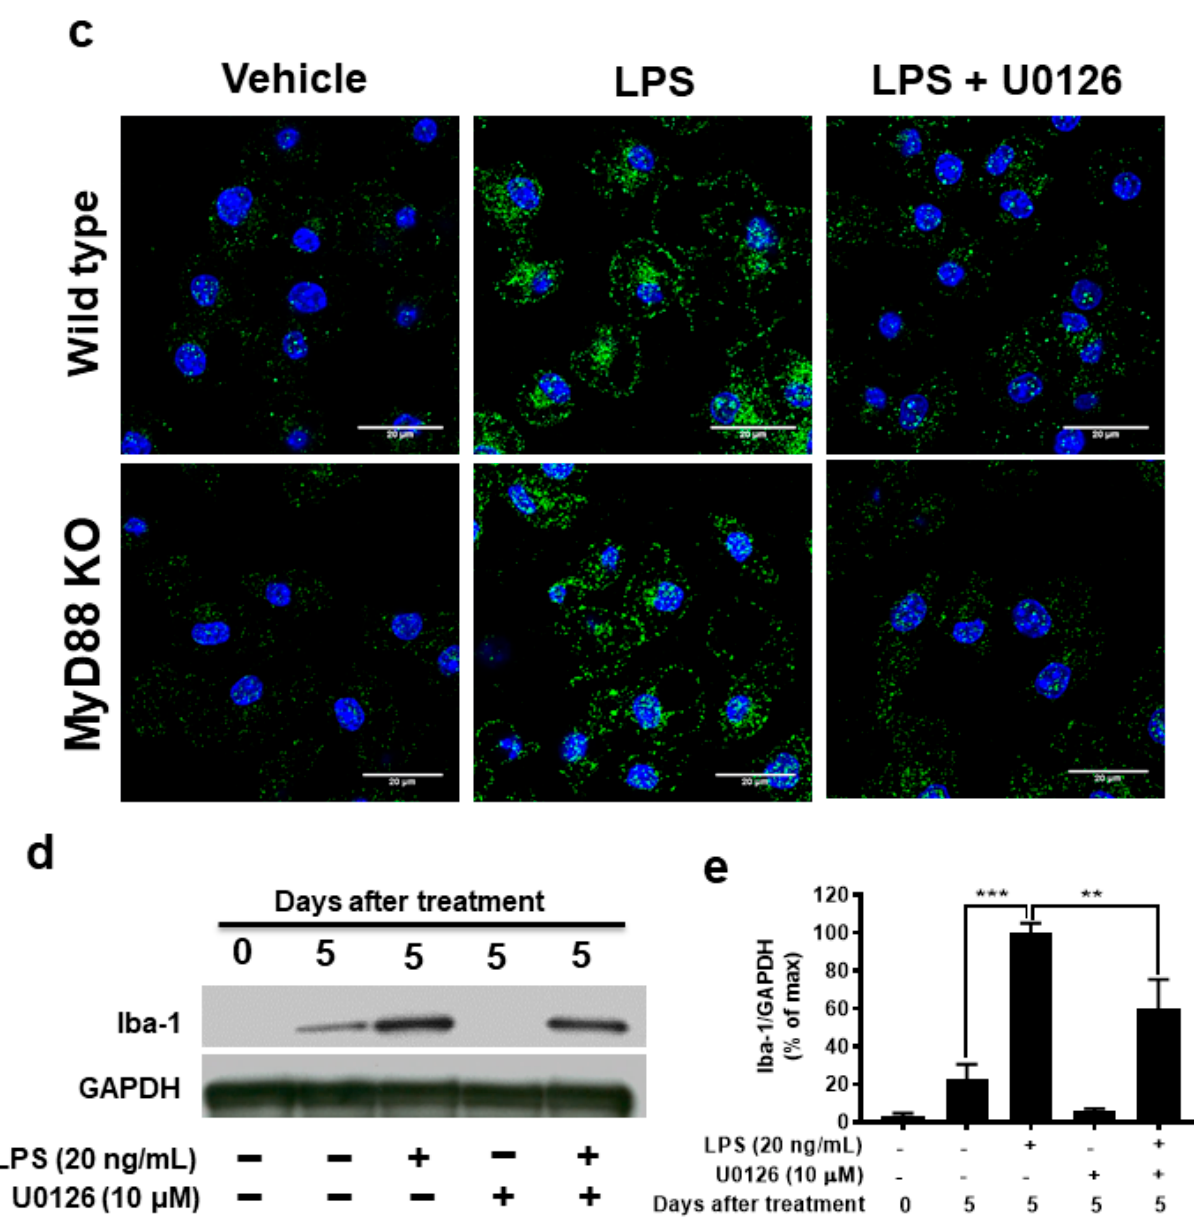
Figure 6. A prolonged increase in ERK1/2 phosphorylation is associated with MAC1-NOX2-elicited reactive microgliosis. Microglia from wild type, MAC1 KO, and MyD88 KO mice were treated with LPS. Cell pellets were collected at various time points for detecting the quantity of both phosphorylated-ERK1/2 or total ERK1/2 ( a ). ( b ) Quantification of ERK1/2 profiles. ( c ) Microglia from wild-type and MyD88 KO mice were stimulated with LPS for 30 min followed by Erk1/2 inhibitor U0126 (10 μ M) for another 30 min. At the end of incubation, cells were fixed and stained with p47 phox , scale bar = 20 μ m. ( d ) Neuron-glial cultures from wild-type mice were stimulated with LPS and followed by treating with ERK1/2 inhibitor one day after LPS stimulation. Five days after U0126 treatment, the cell pellets were collected for Iba-1 Western blot analysis. ( e ) Quantification of Iba-1 density in ( d ). Data show mean ± SEM from 3 independent experiments. * p < 0.05; ** p < 0.01; *** p < 0.001. To further determine whether the long-lasting of ERK1/2 phosphorylation affects the downstream effector NOX2 activation, we stimulated both wild-type and MyD88 KO mi- croglia with LPS for 30 min followed by treatment with ERK1/2 inhibitor U0126 (10 μ M) for another 30 min. In Figure 6c, analysis of immunostaining of p47 phox showed that LPS